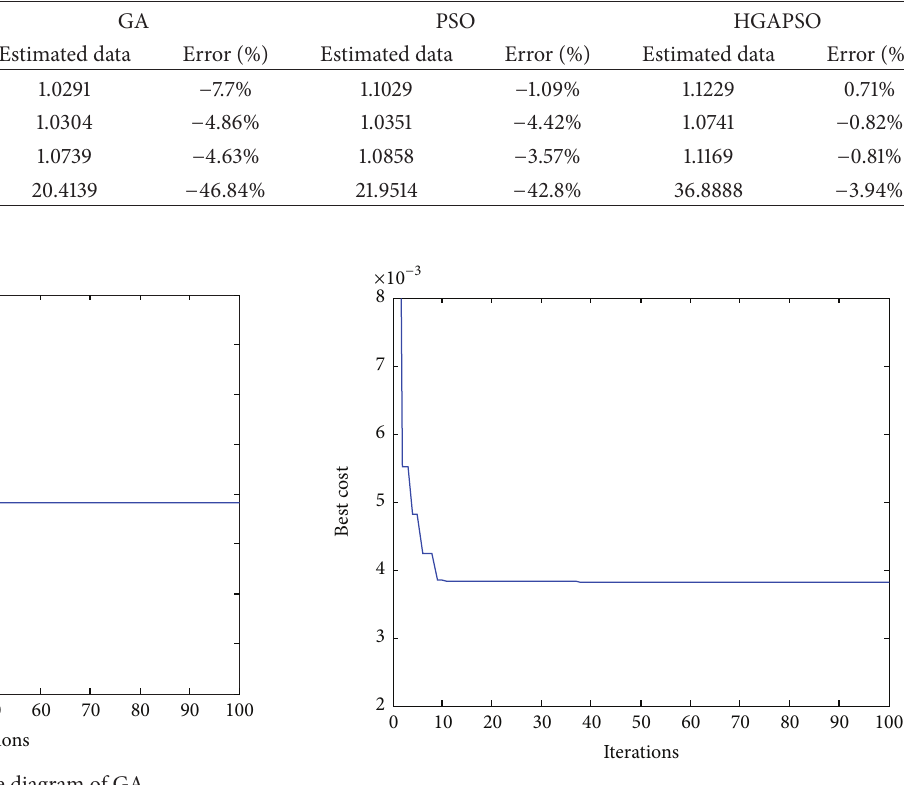
Table 3: The results of the parameter estimation by GA, PSO, and HGAPSO.